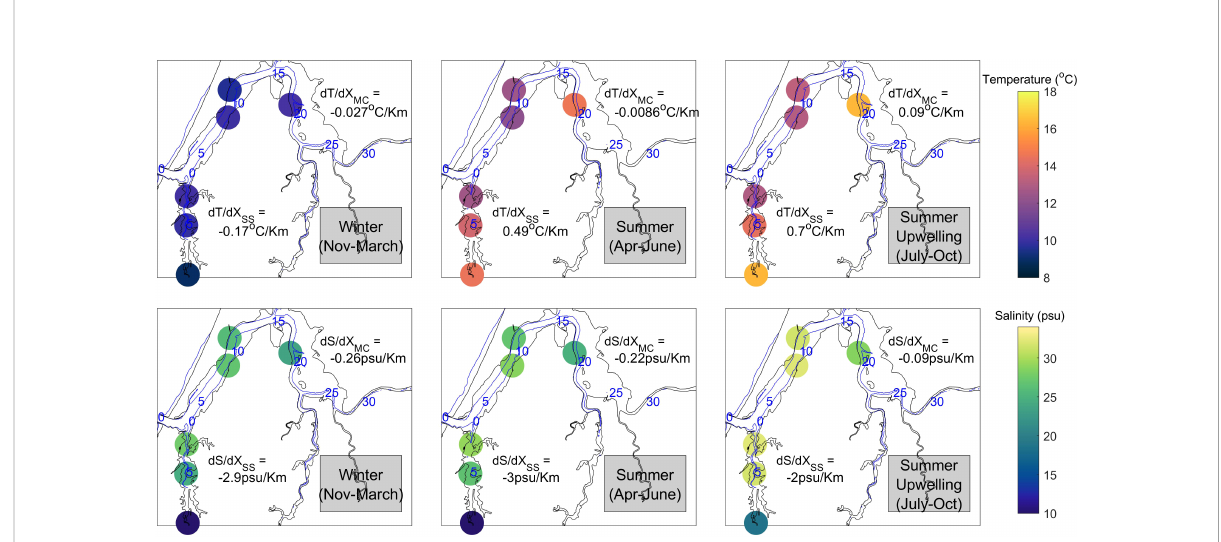
FIGURE 5 Spatial distribution of temperature (top plots) and salinity (bottom plots) 2004-2014 climatology derived at stations inside the Coos Estuary during Winter (left), Summer (middle) and Upwelling (right) time periods. Blue numbers refer to distance (km) from the mouth along the thalweg in the main channel and along the channel in South